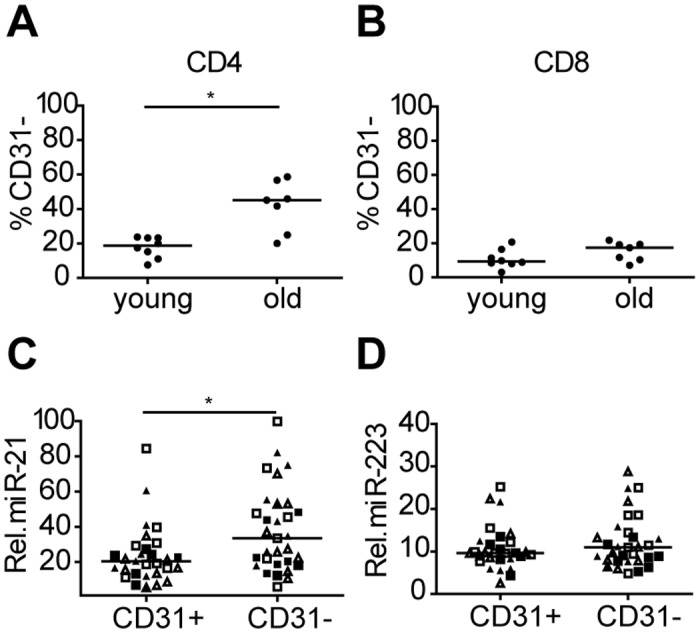
MiR-21 is upregulated in CD31- T cells in the CD45RO- compartment.Percentage of CD31+ and CD31- in (A) CD4+CD45RO- and (B) CD4-CD45RO- T cells in young and old donors. Relative expression of (C) miR-21 and (D) miR-223 in CD31-and CD31+ T-cell subset sorted from the CD45RO- T-cell compartment. MiRNA expression was normalized to the expression of RNU49 (line indicates median). Squares indicate cells from young and triangles indicate cells from old donors. Filled symbols indicate CD4+ T cells and open symbols indicate CD8+ T cells. *p ≤ 0.05.